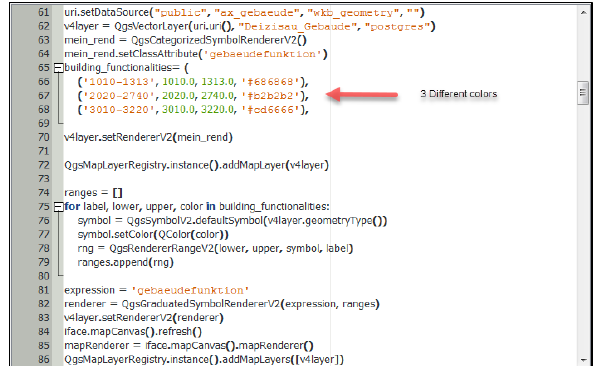
Figure 8: Python code for layer categorization. Different colors are applied for the visualization in QField (see Figure 6).